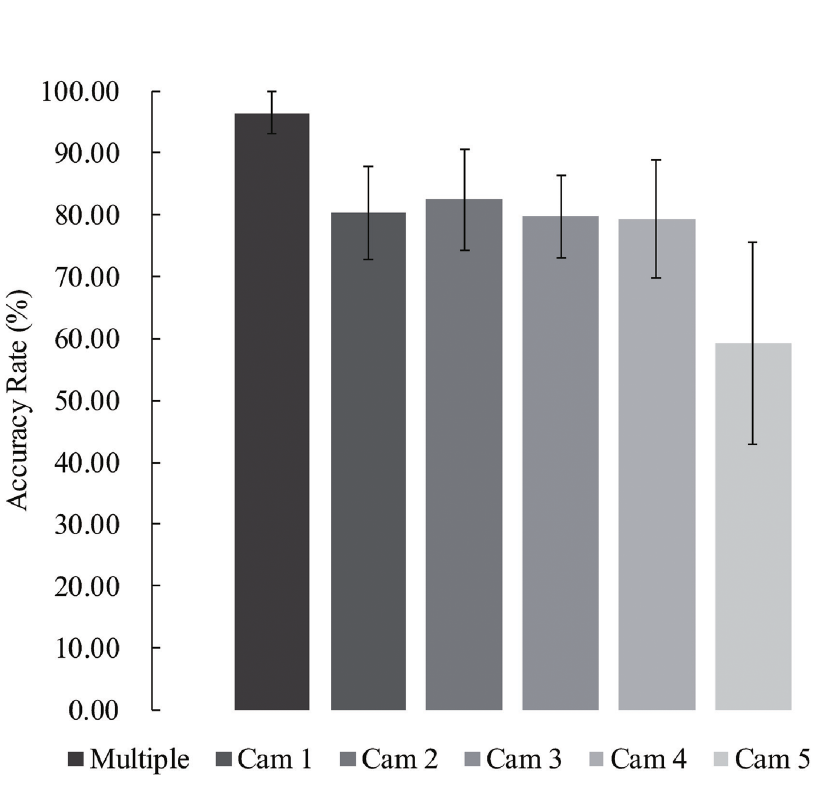
Fig 8. Comparison between multi-view and single-view approaches. Recognition rate of proposed model using multi-view inputs (96.37 ± 3.39%) and single-view inputs from Cam 1 (80.34 ± 7.57%), Cam 2 (82.48 ± 8.10%), Cam 3 (79.70 ± 6.66%), Cam 4 (79.27 ± 9.56%), and Cam 5 (59.19 ±